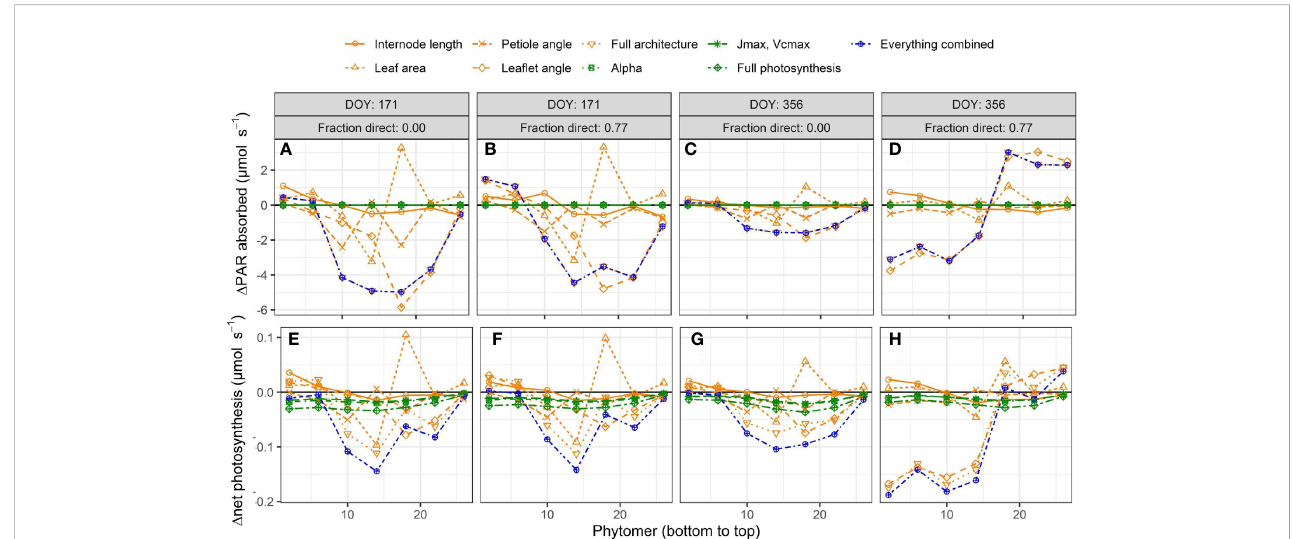
FIGURE 5 Simulated effects of interplant variation in architectural and photosynthesis traits on differences in leaf light absorption (A-D) and net photosynthesis (E- H) at a fraction of 0 (A,C,E,G) or 0.77 direct sunlight (B,D,F,H) and at summer (A,B,E,F) and winter solstices (C,D,G,H). Each simulation is compared to the reference where the rotation of plants relative to their neighbors (0 to 360 ◦ , drawn at random) was the only source of variation. The rotation of the plants relative to their neighbors was kept the same for every model simulation such that any differences in light absorption and net photosynthesis are the result of including interplant variation of architectural and/or photosynthesis traits. Data represent the average of 3 adjacent phytomer ranks (i.e. phytomer rank 2 is the average of phytomer ranks 1 to 3; phytomer rank 6 the average of phytomer ranks 5 to 7) of all hourly time steps in a day from 24 plants (centre 12 plants of the centre two double rows) from fi ve repetitions, at three different planting densities (1.5, 2.4 and 3.3 plants m − 2), resulting in a total of 360 observed